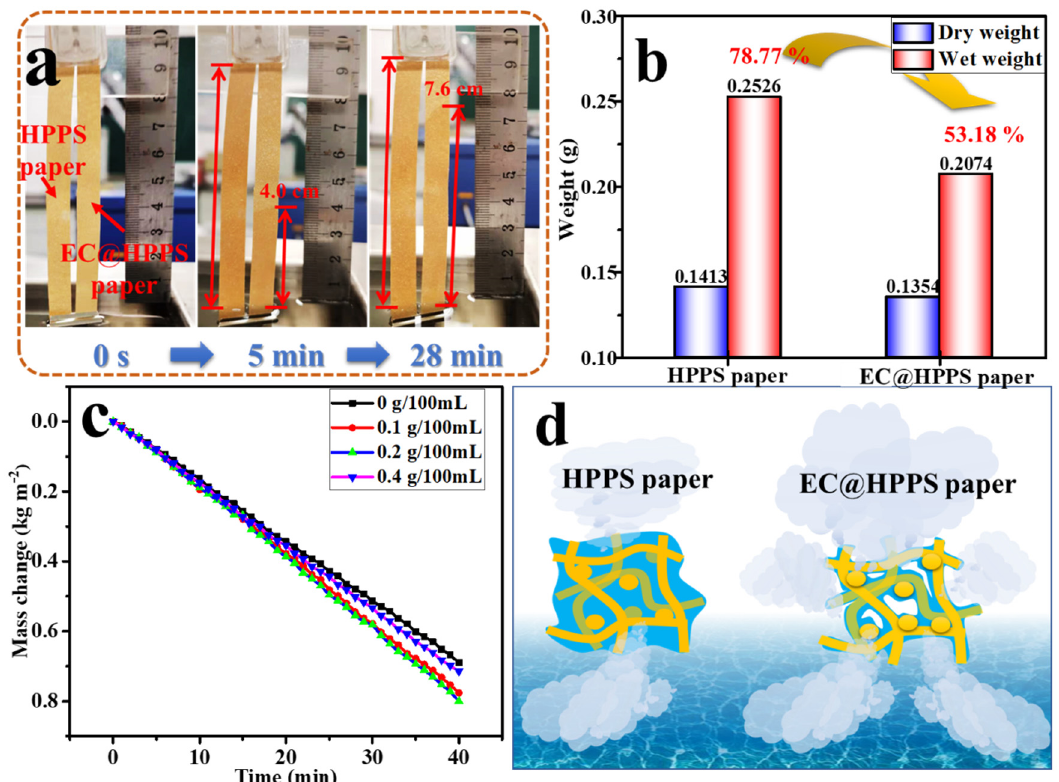
Figure 9. Wicking heights after 5 min and 28 min ( a ) and hydroscopic rate ( b ) of HPPS and papers; ( c ) water mass changes in light of irradiation time with MWCNTs@HPPS paper prepared with different EC solution under 1 sun; ( d ) schematic diagram of water trace distribution on cold evaporation surface of HPPS and EC@HPPS